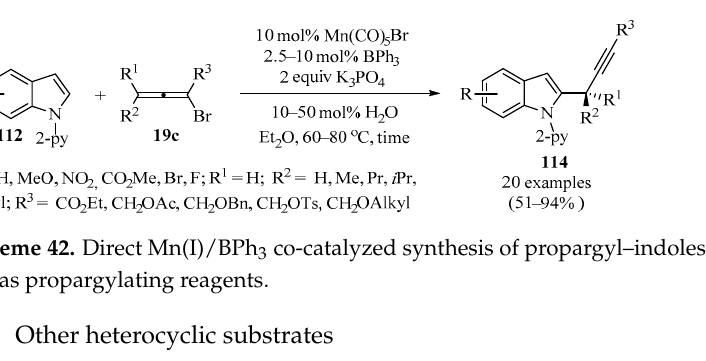
Table 4. Diverse methodologies for the synthesis of propargyl–indole hybrids 113 from substituted propargyl derivatives 54 / 63 and indoles 112 .